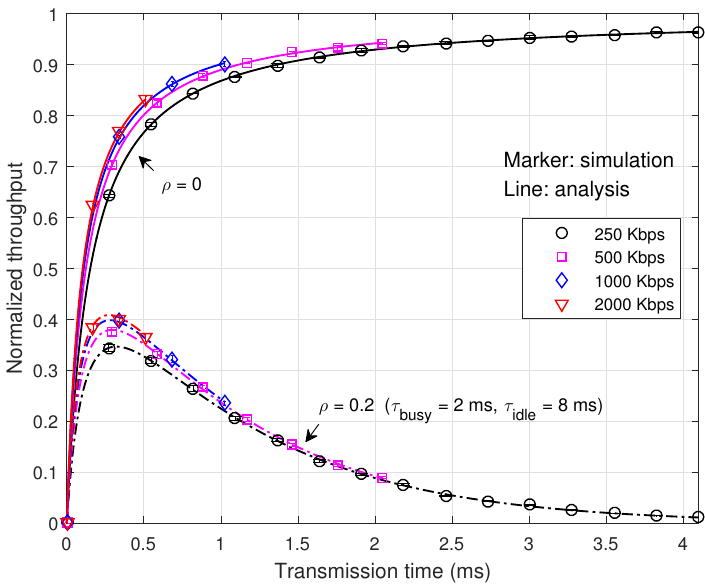
Figure 6. Normalized throughput according to the transmission